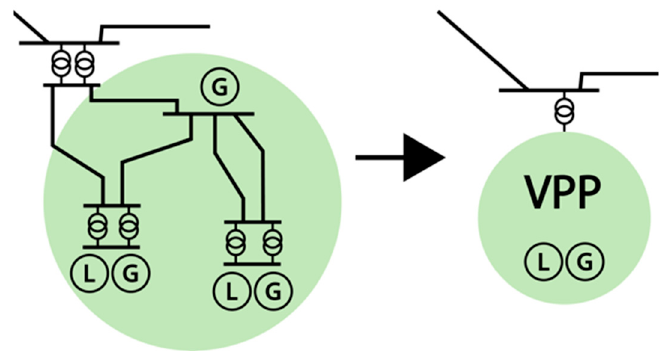
Figure 1. Concept representation of a VPP (adapted fenix-project [12]).